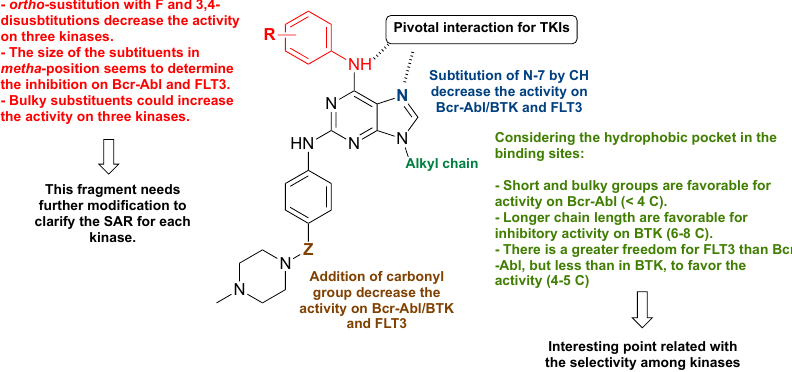
Figure 11. Summary of the main structure – activity relationships found in the present study.